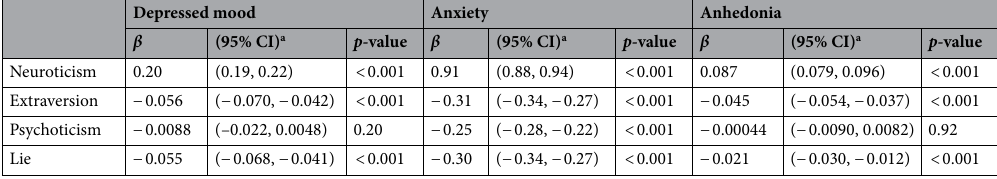
Table 3. Regression coefficients and 95% confidence intervals (CIs) for each underlying symptom dimension in the EPDS for 1 standard deviation increase in each personality scale. EPDS, Edinburgh Postpartum Depression Scale. a Adjusted for age at delivery, parity, mode of delivery, educational attainment, household income, and social isolation during